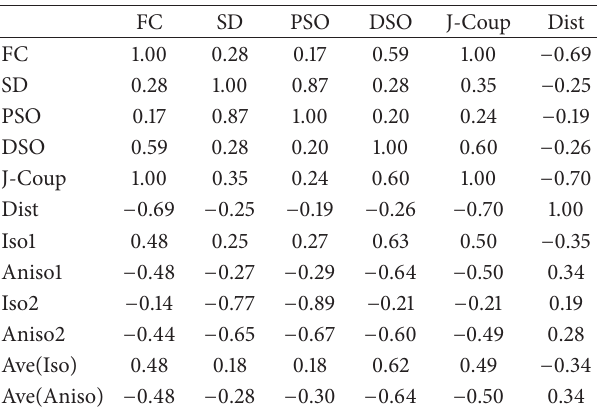
Table6:ThecorrelationsbetweentheRamseyterms,spin-spincou- pling, and isotropic and anisotropic shielding and their interatomic distance.